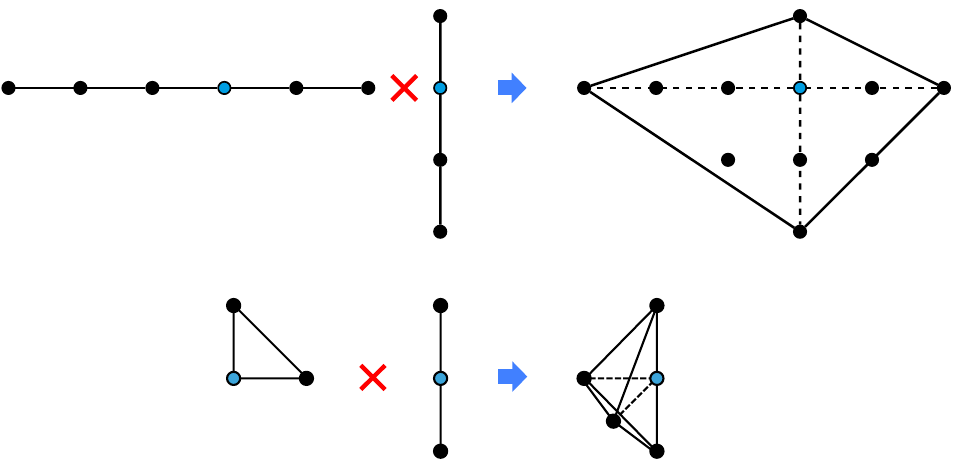
Figure 1. Two examples of the action of the Calabi-Yau product on toric diagrams. The first line is an example of CY